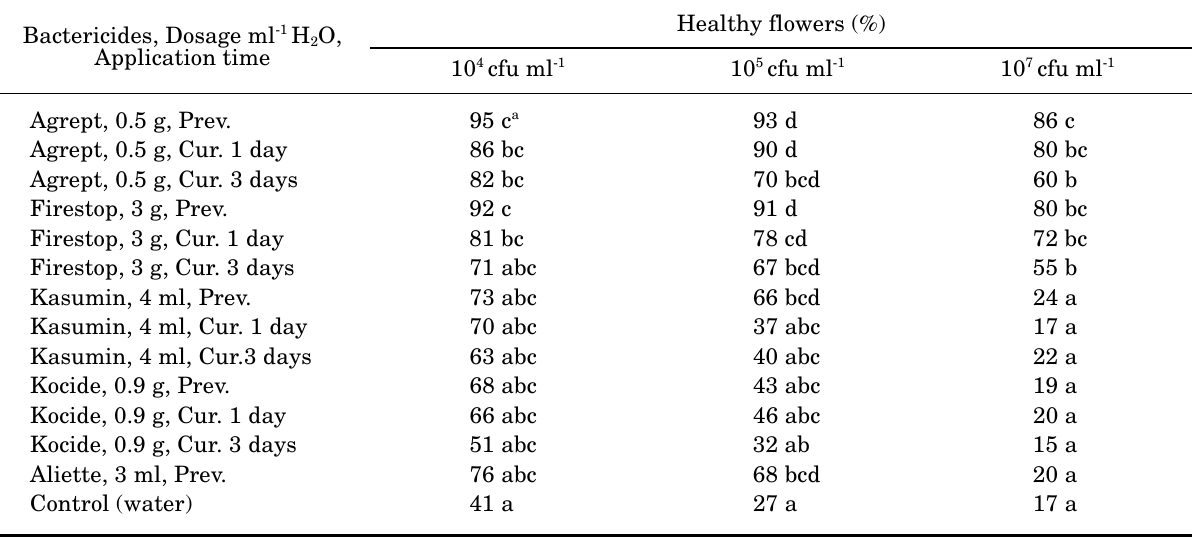
Table 5. Effectiveness of preventive (Prev.) and curative (Cur.) sprays on pear flowers (var. Kristalli) artificially inoculated with Erwinia amylovora at concentrations of 10 4 ,10 5 and 10 7 cfu ml -1 in 1995. Healthy flowers (%) Bactericides, Dosage ml -1 H 2